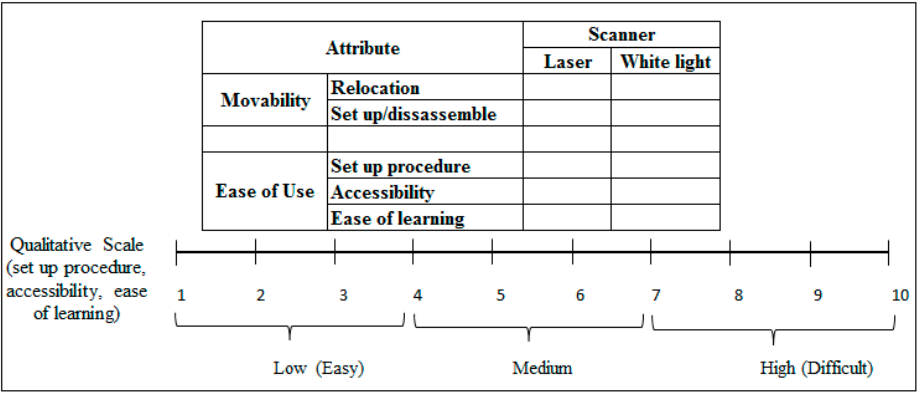
Figure 18. Scale provided to the users for rating different scanners.